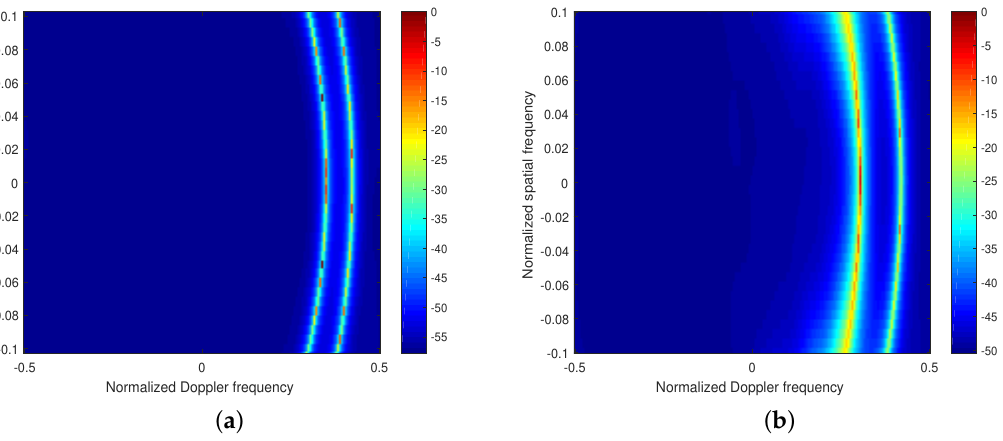
Figure 7. Clutter spectra ( a ) Ideal case ( b ) The proposed method in the PA-FDA dual-mode radar.